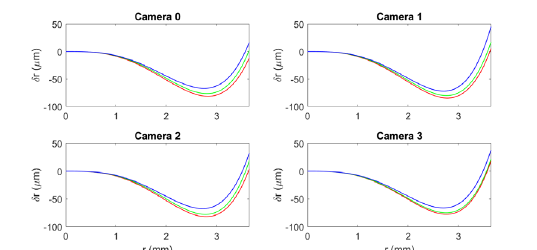
Figure 10. Case 1 GoPro Hero 5 radial lens distortion profiles.